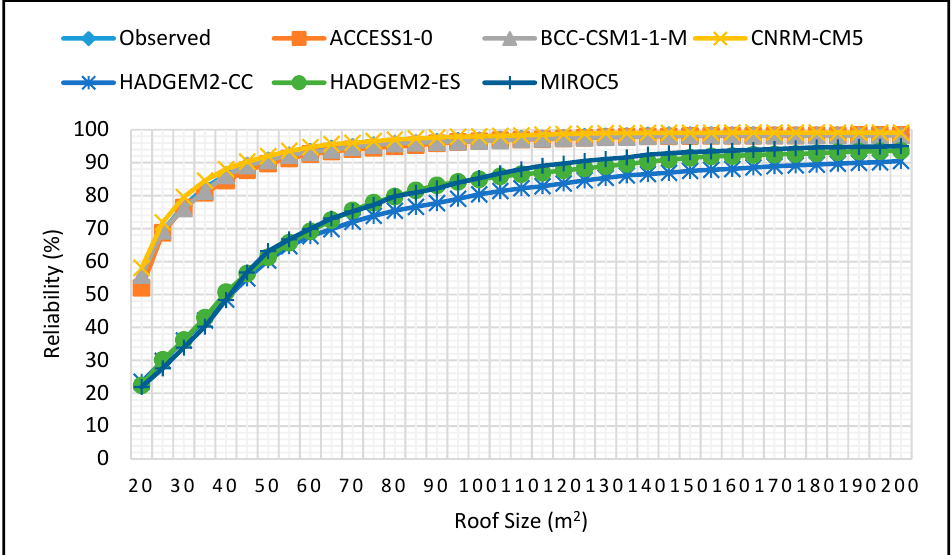
Figure 29. Reliability projections for MAM season for 2 m 3 tank size for 2060–2090 period. Water 2018 , 10 , 71